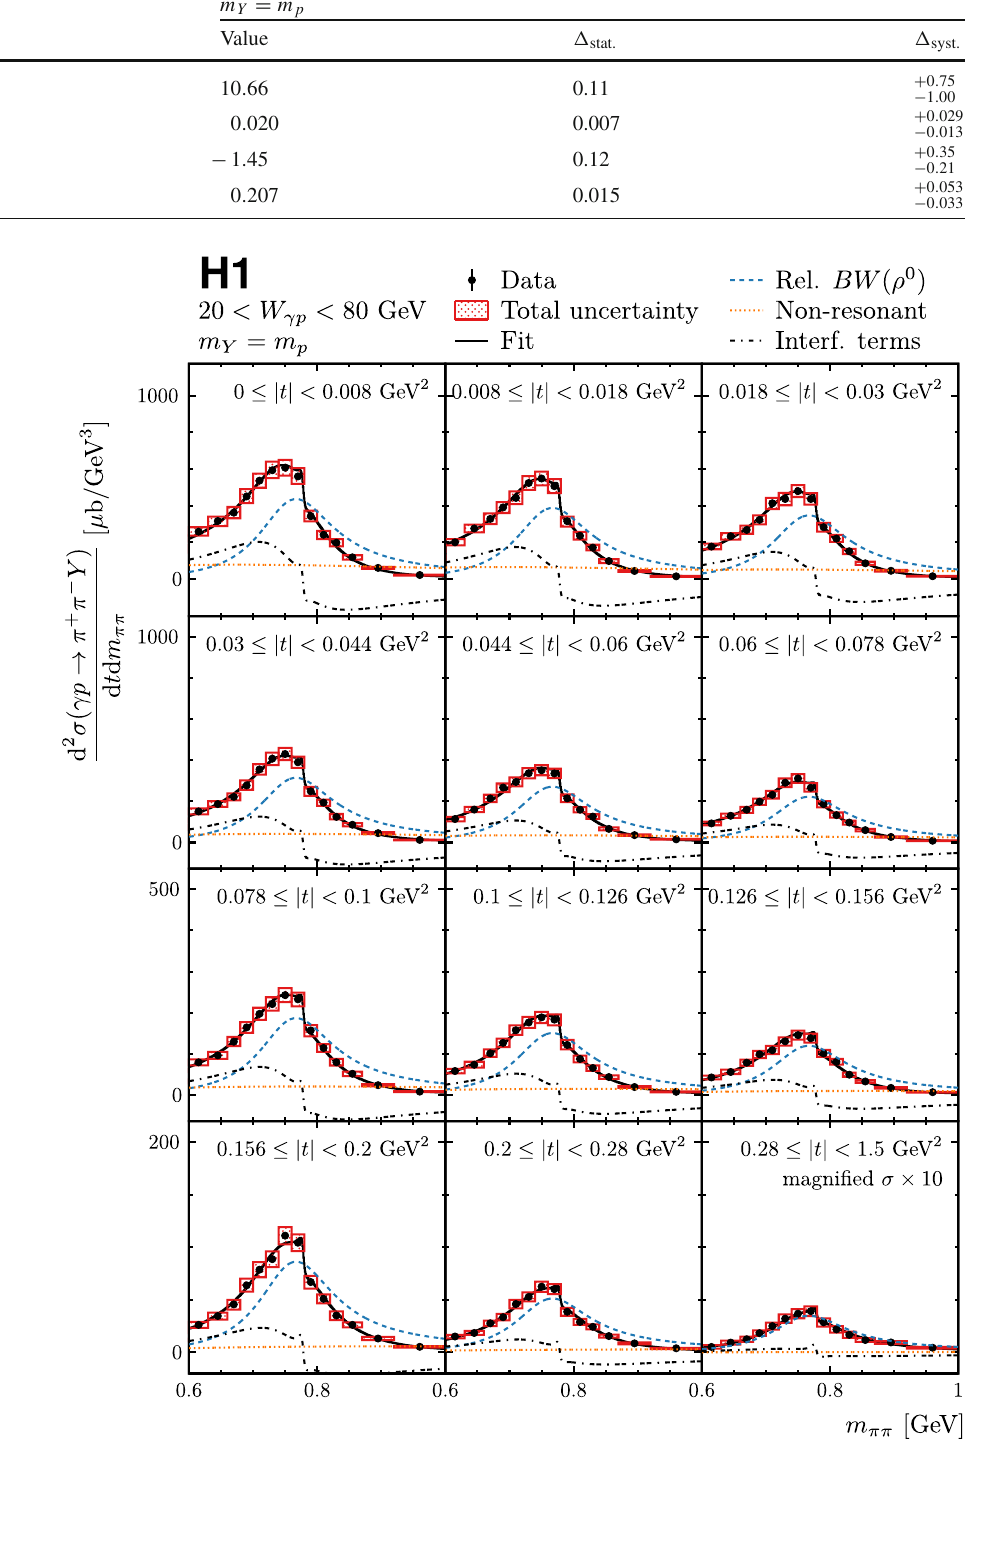
Table 9 Fit parameters for the fit of the energy dependence of the elastic ρ 0 meson photoproduction cross section in the range 2 < W γ p < 200 GeV. The nominal fit values and statistical and sys-